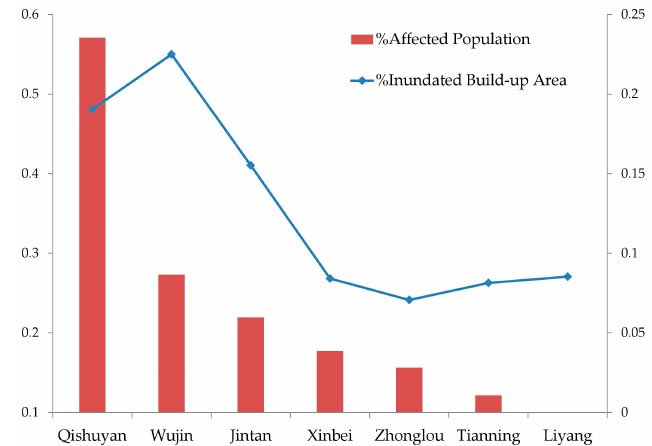
Figure A2. Comparison between the modeling results and local government damage report: each red bar represents the proportion of inundated build-up area (based on modeling results) and the blue line represents the proportion of affected population reported by the government in each district.